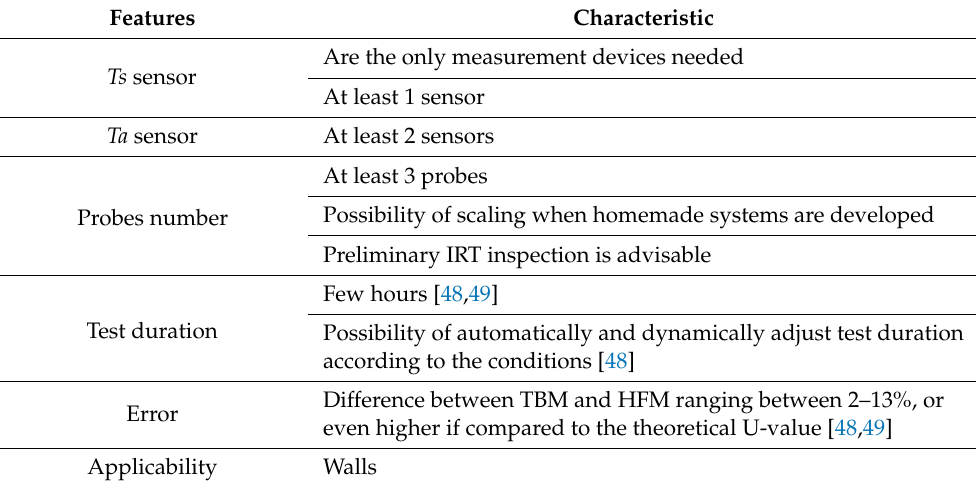
Table 9. Characteristics of the thermometric method (source: authors’ elaboration).